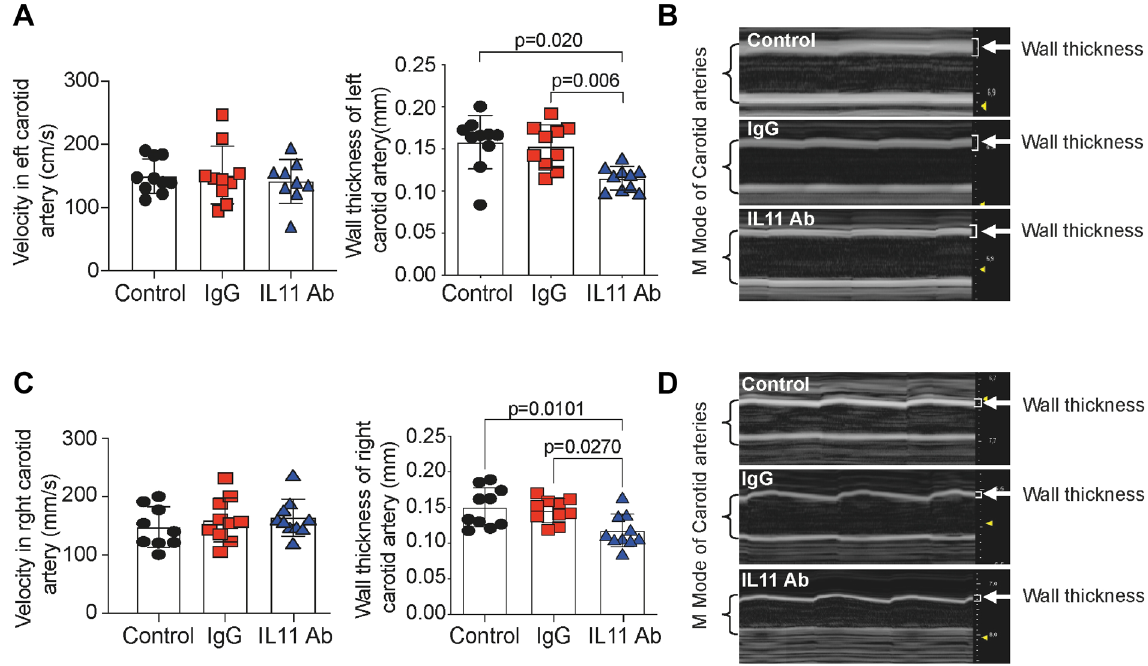
Figure 2. The effect of anti-IL-11 antibody (X203) treatment on vessel wall thickness. ( A ) Velocity and wall thickness of injured left carotid artery (N = 10/group, One-way ANOVA, Tukey’s multiple comparison test, Values ± SD). ( B ) Representative M-Mode images of injured left carotid artery. Brackets show carotid artery size, and arrows point out the measured wall thickness. ( C ) Velocity and wall thickness of uninjured right carotid artery (N = 10/group, One-way ANOVA, Tukey’s multiple comparison test, Values ± SD). ( D ) Representative M-Mode images of uninjured right carotid artery. Brackets show carotid artery size, and arrows point out the measured wall